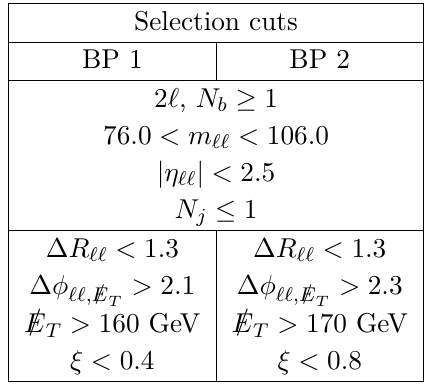
are the total event yield from the gluon fusion NLO 4 F